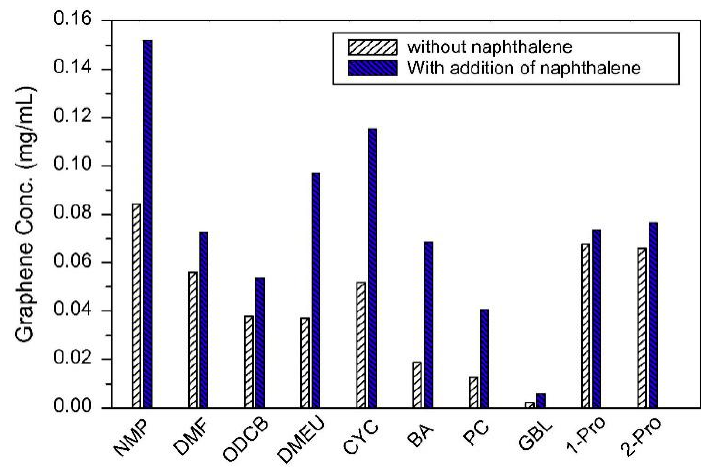
Figure 17. Concentrations of graphene sheets dispersed in organic solvents with or without addition of naphthalene. Reproduced from [84]. Copyright Elsevier, 2014.